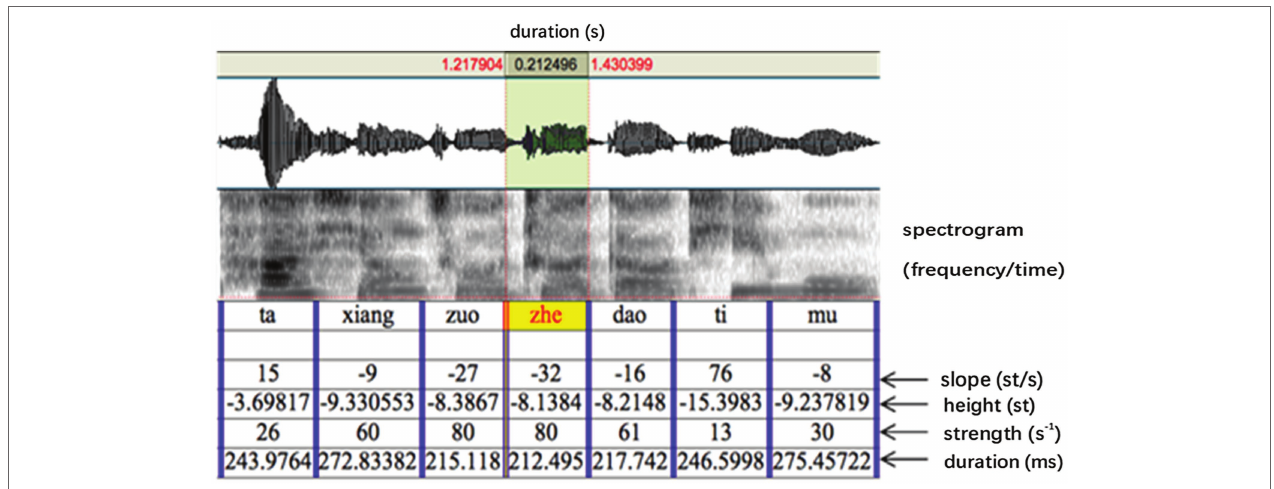
FIGURE 3 | The segmentation of the stimulus sentence (“ zhe ” as the target syllable) with parameters automatically derived from PENTAtrainer1 through analysis by synthesis (Xu and Prom-on,